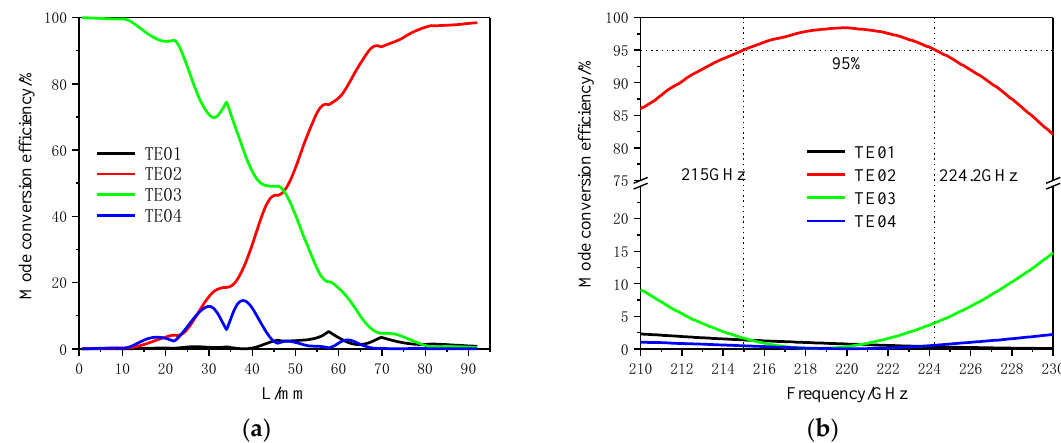
Figure 3. The calculation results of TE 03 -TE 02 mode converter: ( a ) Mode conversion efficiency along z of the mode converter; ( b ) Mode conversion efficiency in the different frequencies.